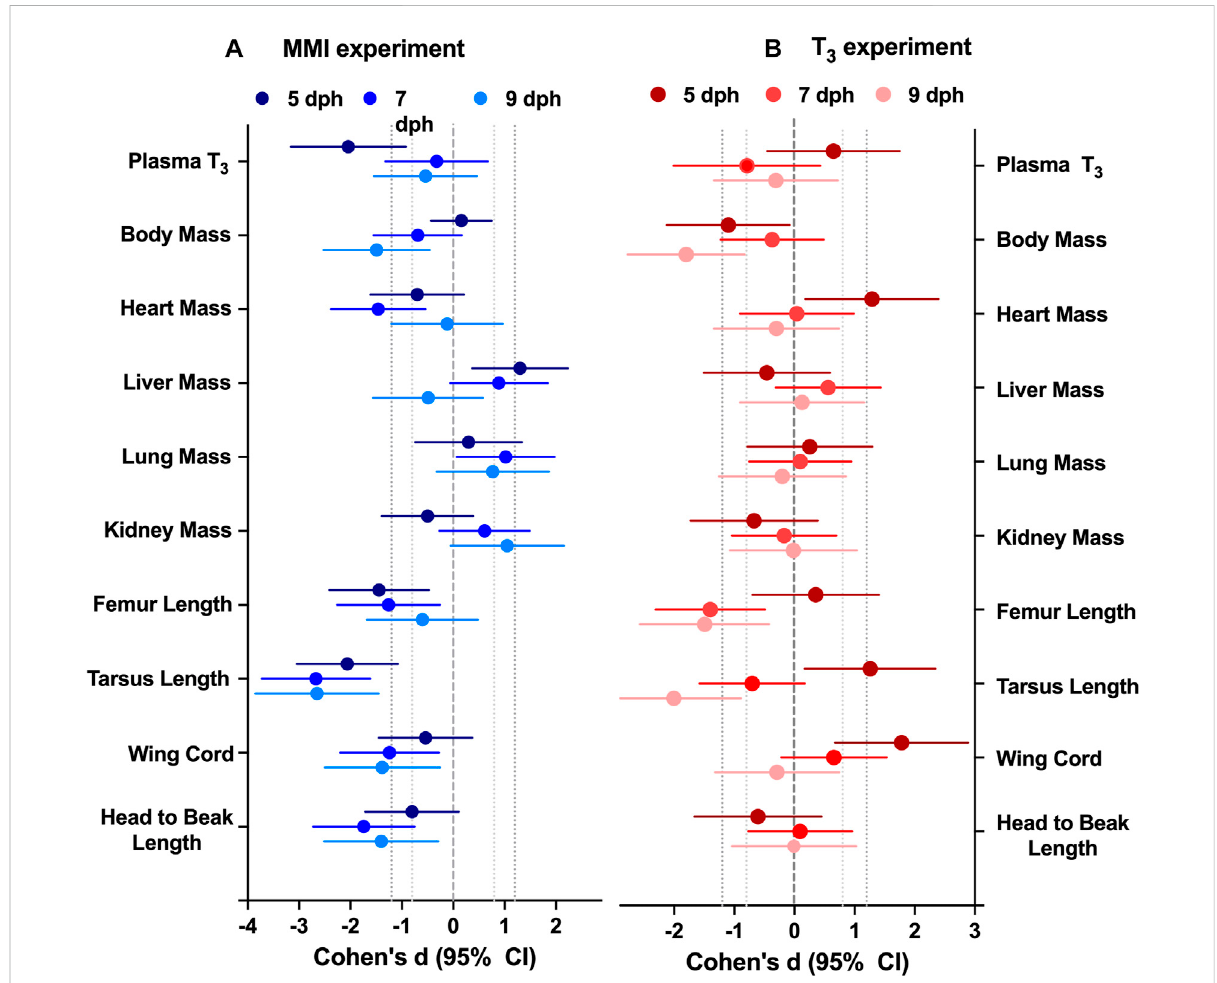
FIGURE 2 Effect of altering thyroid plasma levels during the fi rst half of nestling period on morphology differed between (A) hypothyroid and (B) hyperthyroidtreatments.DatapresentedastheeffectsizeestimateCohen ’ sd±95%con fi denceintervalscomparingtheeffectofthetreatmentwith control values within an experimental year. Cohen ’ s d effect size are calculated from the ANCOVA estimated marginal means with body mass as a covariate to remove the effect of body mass. n = 7 – 10 per